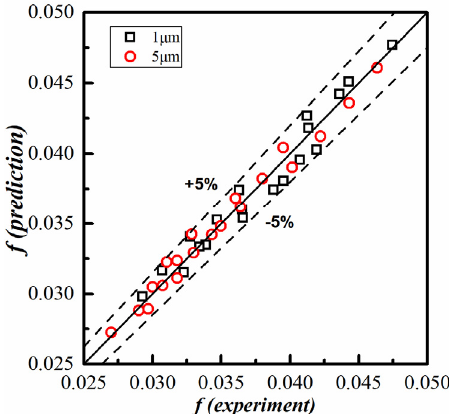
Figure 9. Comparison of Nu between the experiments and the predictions from the regression equation.